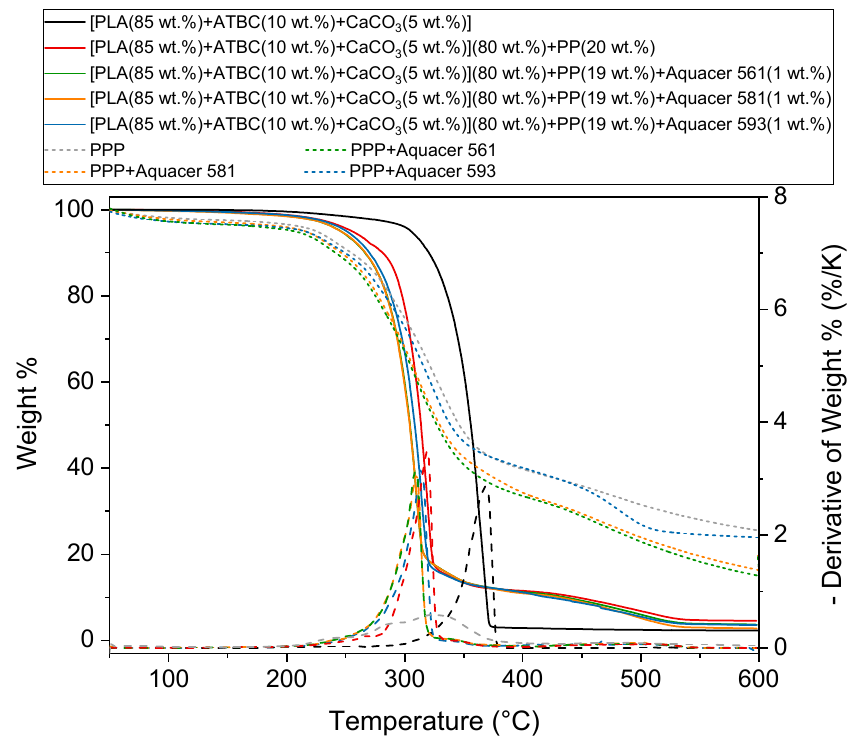
Figure 1. Thermogravimetric curves of the uncoated and coated potato pulp powder (PPP), and the poly(lactic acid) (PLA) based matrix and biocomposites indicated in the legend at 10 K/min under nitrogen flow (estimated error: ± 0.2 wt.%). The dotted lines are the derivative of the wt.% curves.